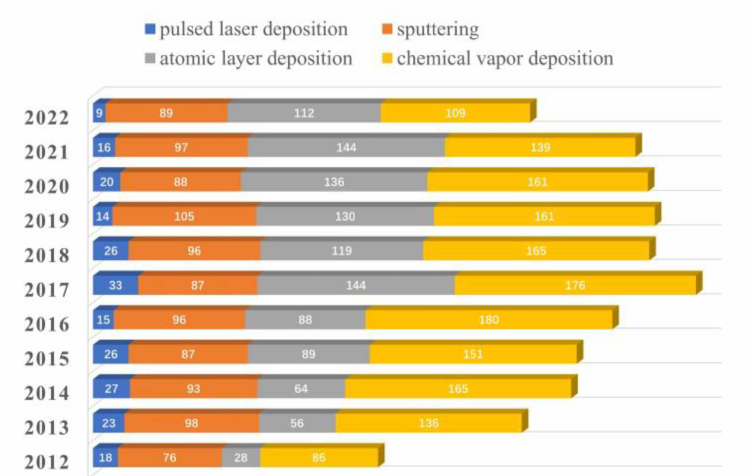
Figure 1. The number of papers published for lithium-ion batteries using coating techniques from 2012 to 2022 on the Web of